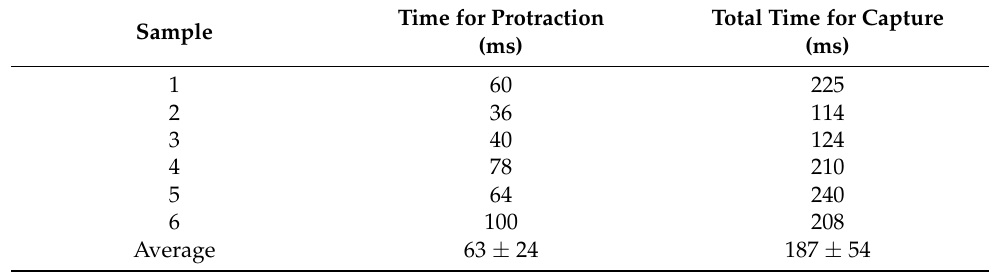
Table 1. Time taken for protraction of labial palp and capture of the prey.